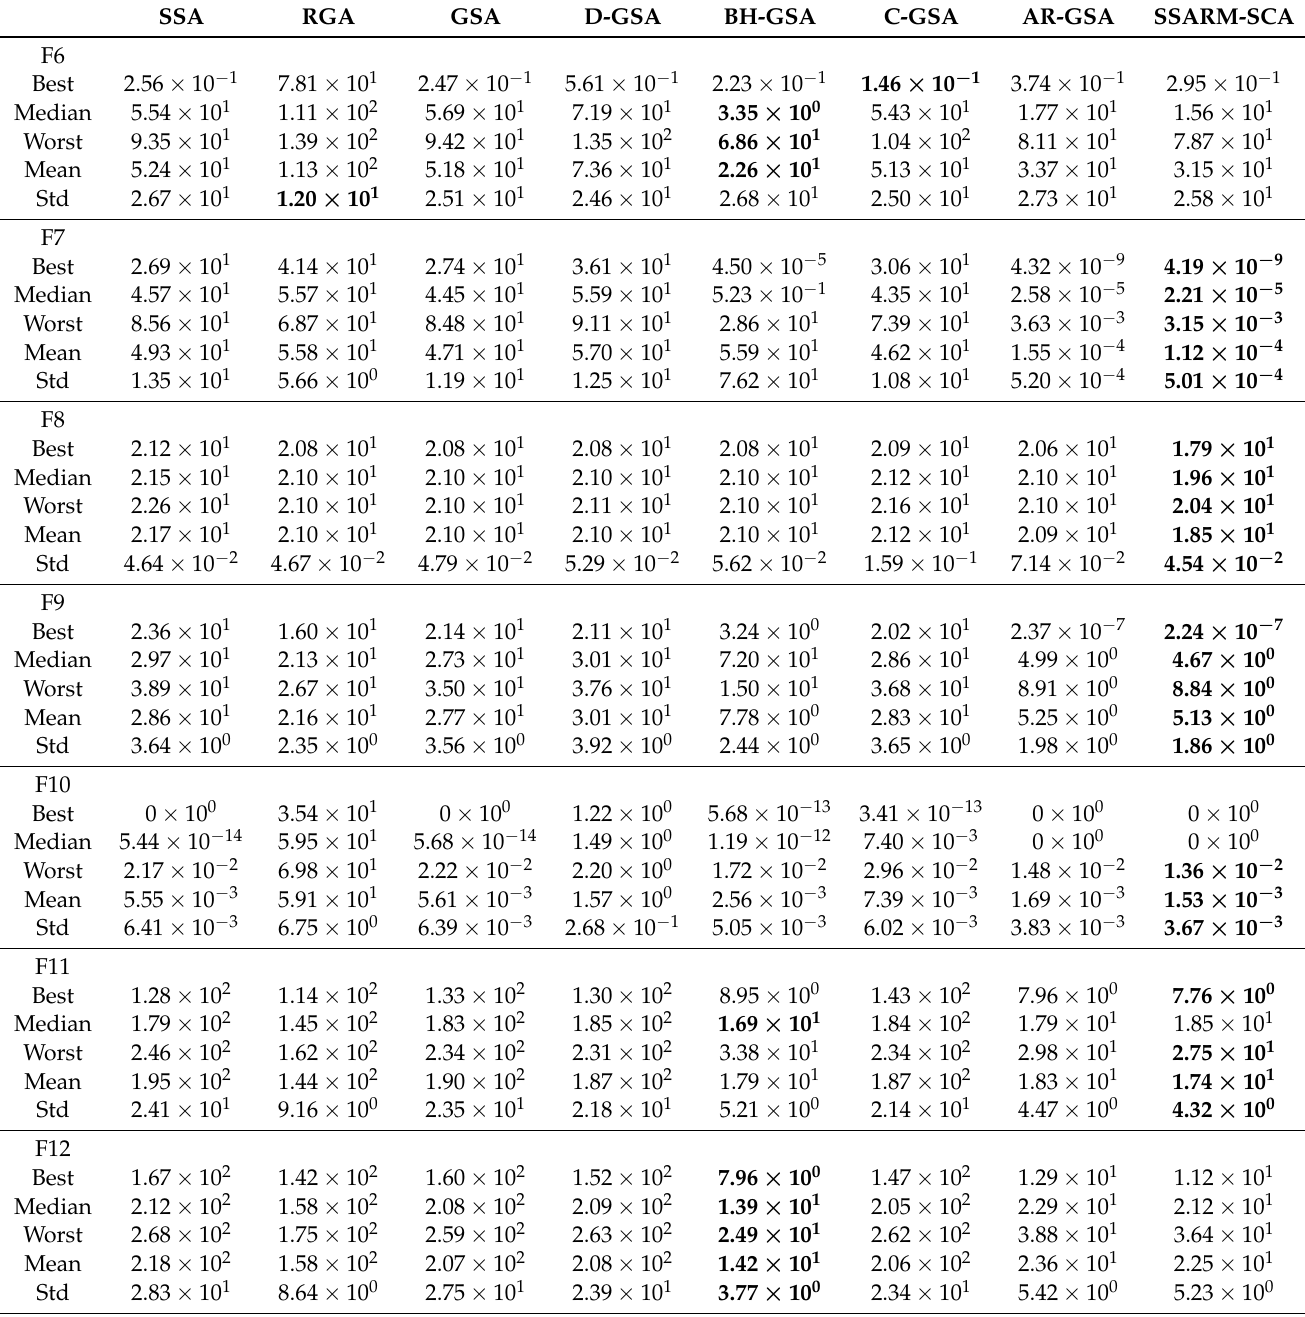
Table 3. Comparative analysis between SSARM-SCA and other SOTA methods for CEC2013 multi- modal